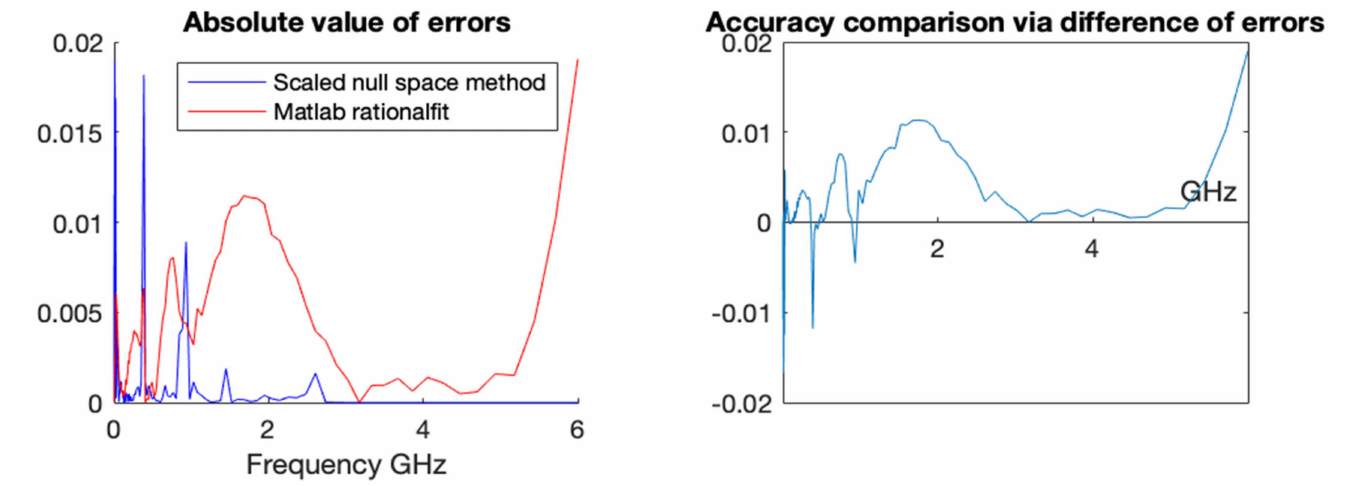
Figure 9. A pointwise comparison of fitting errors in example above. Left-hand side graph shows absolute value of errors of our method scaled null space versus Matlab rationalfit. Right-hand side graph represents difference between errors in rationalfit and our method, where positive y values indicate how much rationalfit is less accurate and negative y values show how much our method is less accurate. Range of errors in rationalfit is [2.5593 × 10 − 6 , 0.0190], while with scaled null space range is [8.8818 × 10 − 16 , 0.0190], which emphasizes advantage in accuracy with our method.